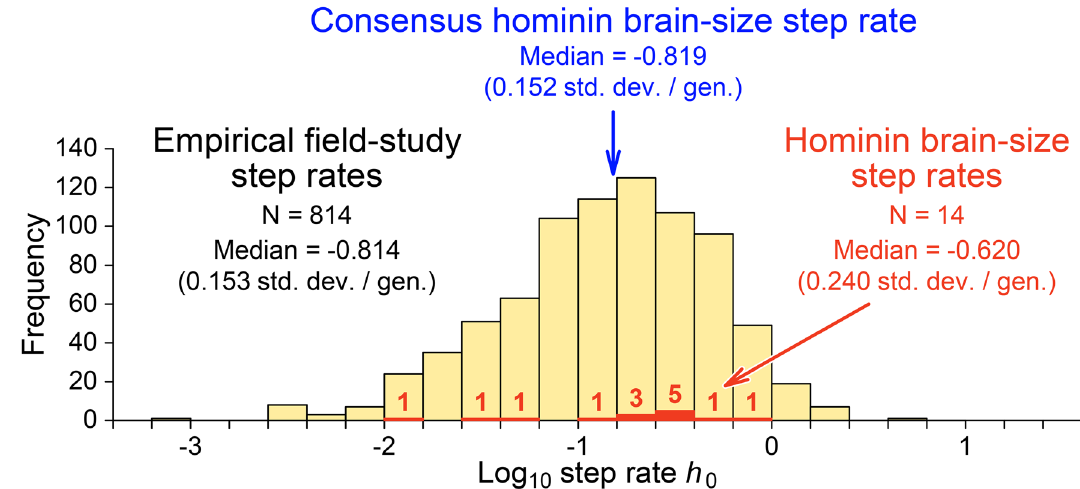
Figure 2. Hominin brain-size step rates for the 14 case studies analyzed here and summarized in Supplementary Table 2 (red), compared to a large sample of modern biological field-study step rates (background histogram 17 ). Step rates are calibrated in phenotypic standard deviations per generation on the generation-to-generation time scale of the evolutionary process. The median log 10 step rate of − 0.620 ( h 0 = 0.240) for hominin case studies is slightly higher than the median log 10 step rate of − 0.814 ( h 0 = 0.15) documented in